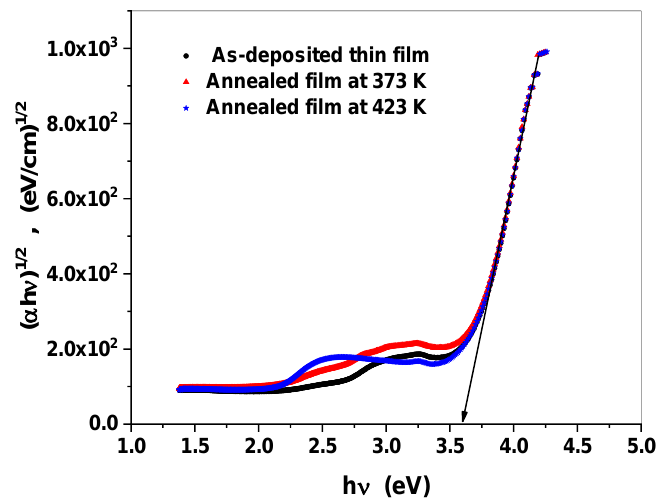
where G is the probability parameter for the transition. Figure 14 shows the indirect optical band gap determined by plotting (𝛼ℎ𝜈) 2 versus ( ℎ𝜈 ) for compound 4 thin films. The value of the indirect optical transitions obtained from the graph was 𝐸 𝑔𝑖𝑛𝑑 = 3.6 𝑉 for both the as-deposited and annealed thin films.